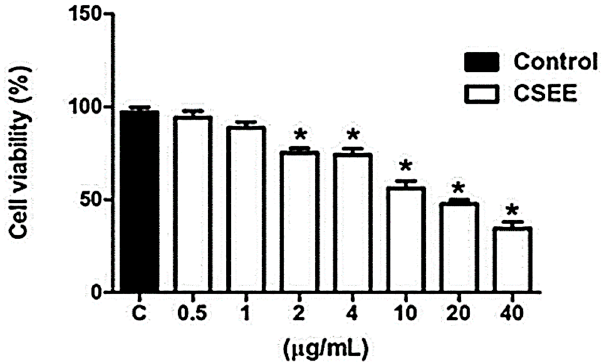
Figure 4. Effects of CSEE on SH-SY5Y cell line viability. Cells were treated with different concentrations of CSEE for 24 h, and the IC 50 was defined as the study test concentration (20 µg/mL). Data shown are representative of three independent experiments. The values are expressed as mean ± SEM and * p < 0.05 indicates statistical difference (unpaired t -test).